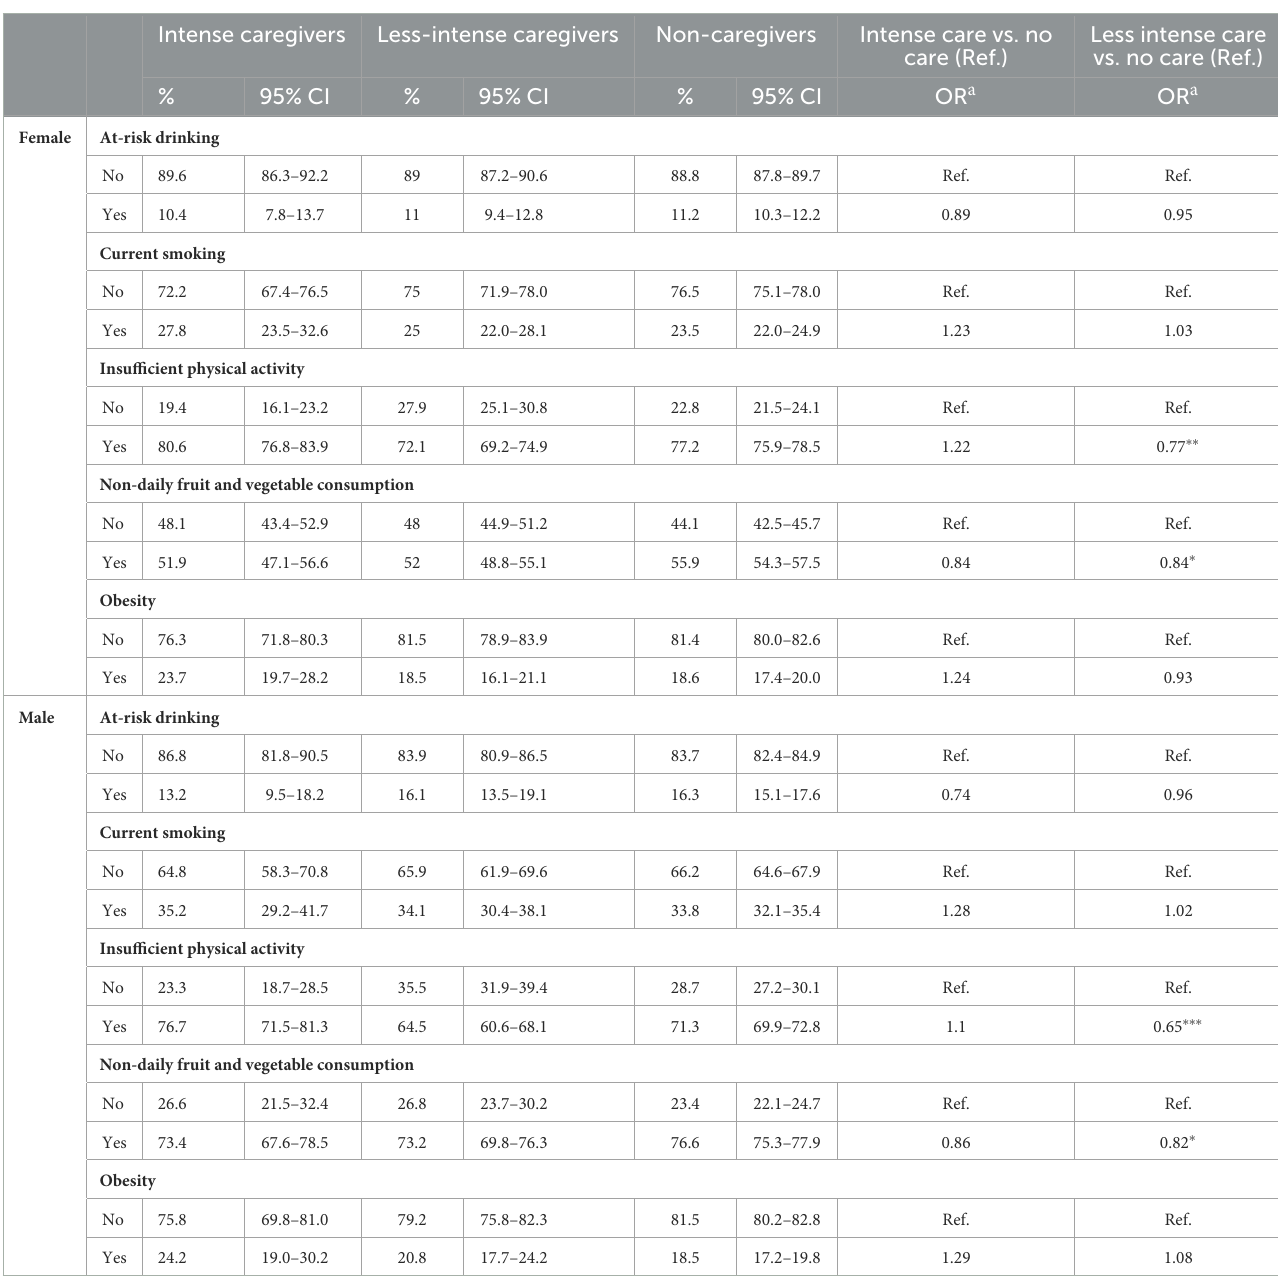
TABLE 4 Health behavioral risk factors of caregivers and non–caregivers by gender (weighted analyses). Intense caregivers Less-intense caregivers Non-caregivers Intense care vs. no